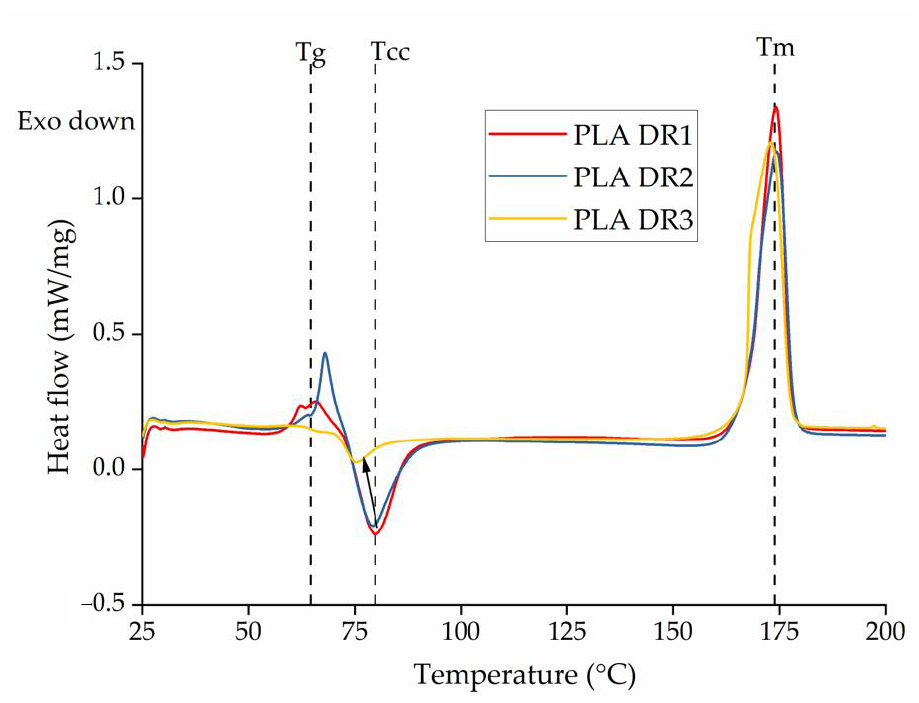
Figure 10. DSC thermogram of PLA yarns drawn at different ratios. The higher crystallinity at an SSD ratio of 3 was also accompanied by a lower T cc